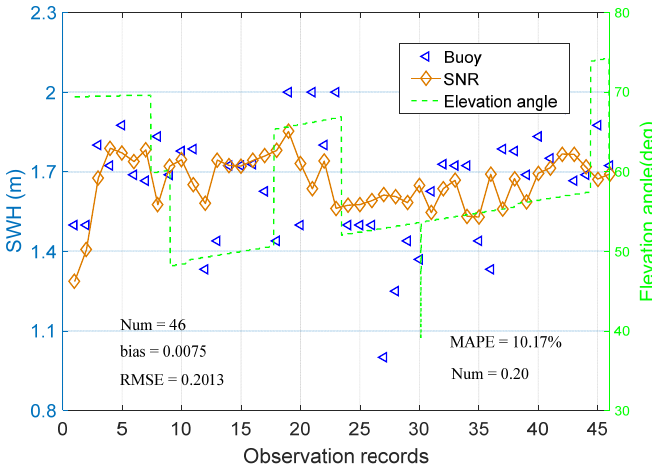
Figure 7. Retrieval results of the traditional algorithm.